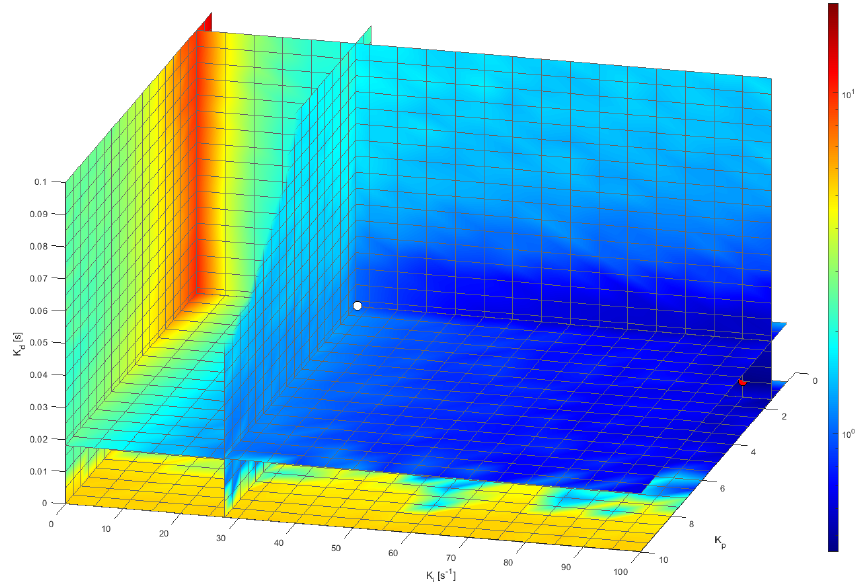
Figure 20. A 3D representation of the NIAE of the PID controller according the planes defined by the 𝐾 𝑝 , 𝐾 𝑖 and 𝐾 𝑑 parameters. The white point depicts the location of the baseline values proposed by the FRB PID Tuner procedure. The leftmost plane is for 𝐾 𝑖 = 0 s −1 and the bottom plane is for 𝐾 𝑑 = 0 s .